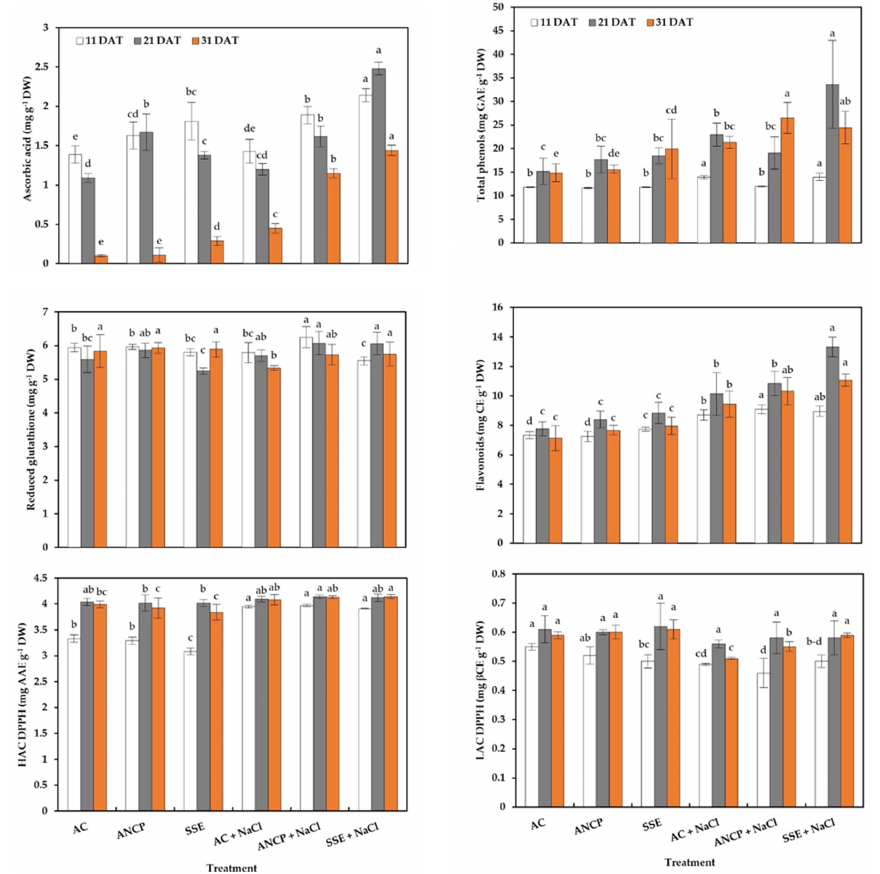
Figure 5. Hydrophilic antioxidants and antioxidant capacity in the leaves of tomato seedlings. Different letters within each column indicate significant differences between treatments (LSD, p ≤ 0.05).